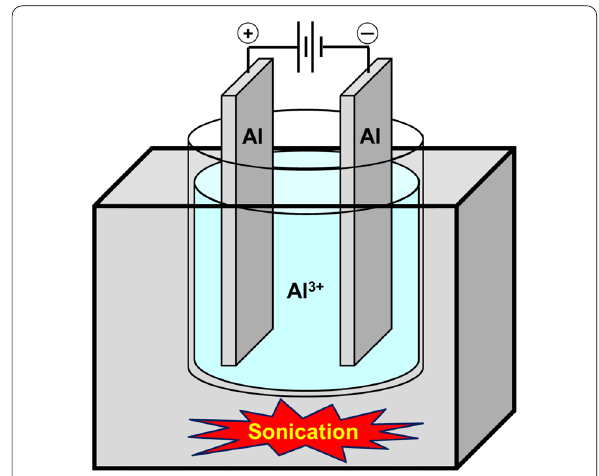
Fig. 1 Illustration of set‑up of fabrication of metallic Al nanoparticles by electrolysis in aqueous